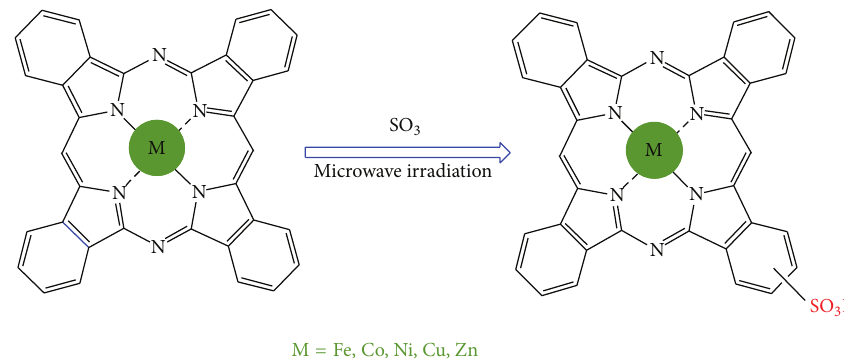
Figure 1: Synthetic route of sulfonated phthalocyanine metals via microwave-promoted procedure.